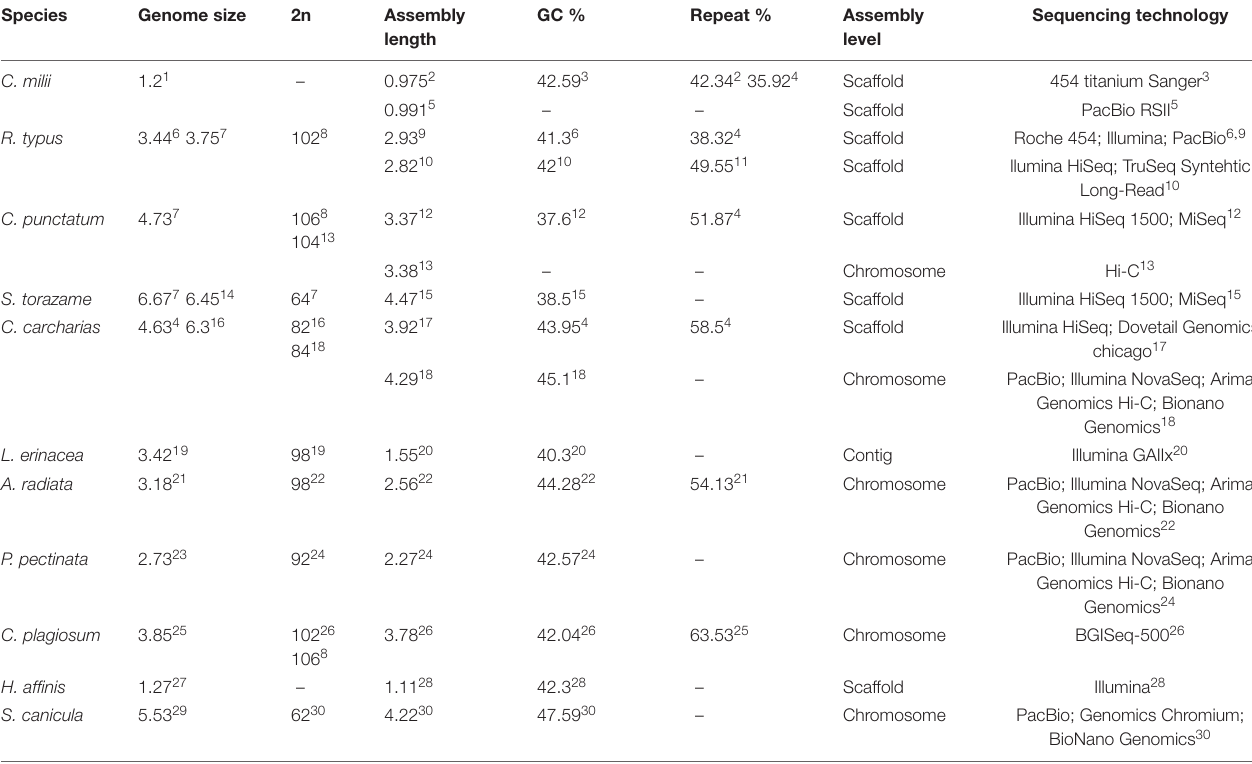
TABLE 1 | Current knowledge of chondrichthyan genomes to date. Species Genome size